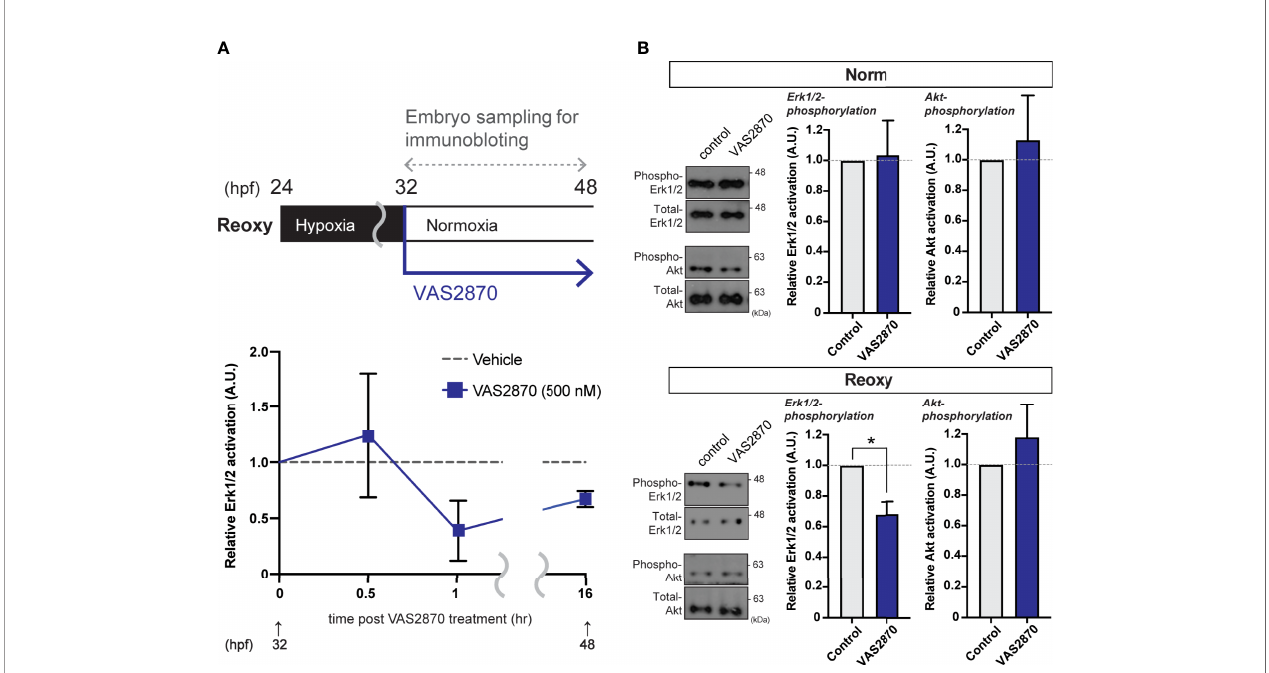
FIGURE 4 | Nox-mediated generation of H 2 O 2 is crucial for the hypoxia/re-oxygenation-induced Erk1/2-phosphorylation. (A) Time-course Erk1/2 phosphorylation changes of the VAS2870-treated embryos. Outline of experimental schedule is shown above the data. Reoxy embryos treated with or without VAS2870 were sampled at various timing, and the Erk1/2-phosphorylation levels were tested by immunoblotting. Relative Erk1/2-phosphorylation levels were shown as mean ± SE of 2-3 independent assays. (B) Erk1/2- and Akt- phosphorylation changes of the VAS2870-treated embryos. Embryos treated with or without VAS2870 (500 nM) were sampled at 48 hpf (16 hr post-re-oxygenation), and the Erk1/2- and Akt-phosphorylation levels were tested by immunoblotting. Relative Erk1/2- and Akt- phosphorylation levels were shown as mean ± SE of 2-3 independent assays. The asterisk (*) denotes statistical difference at P<0.05